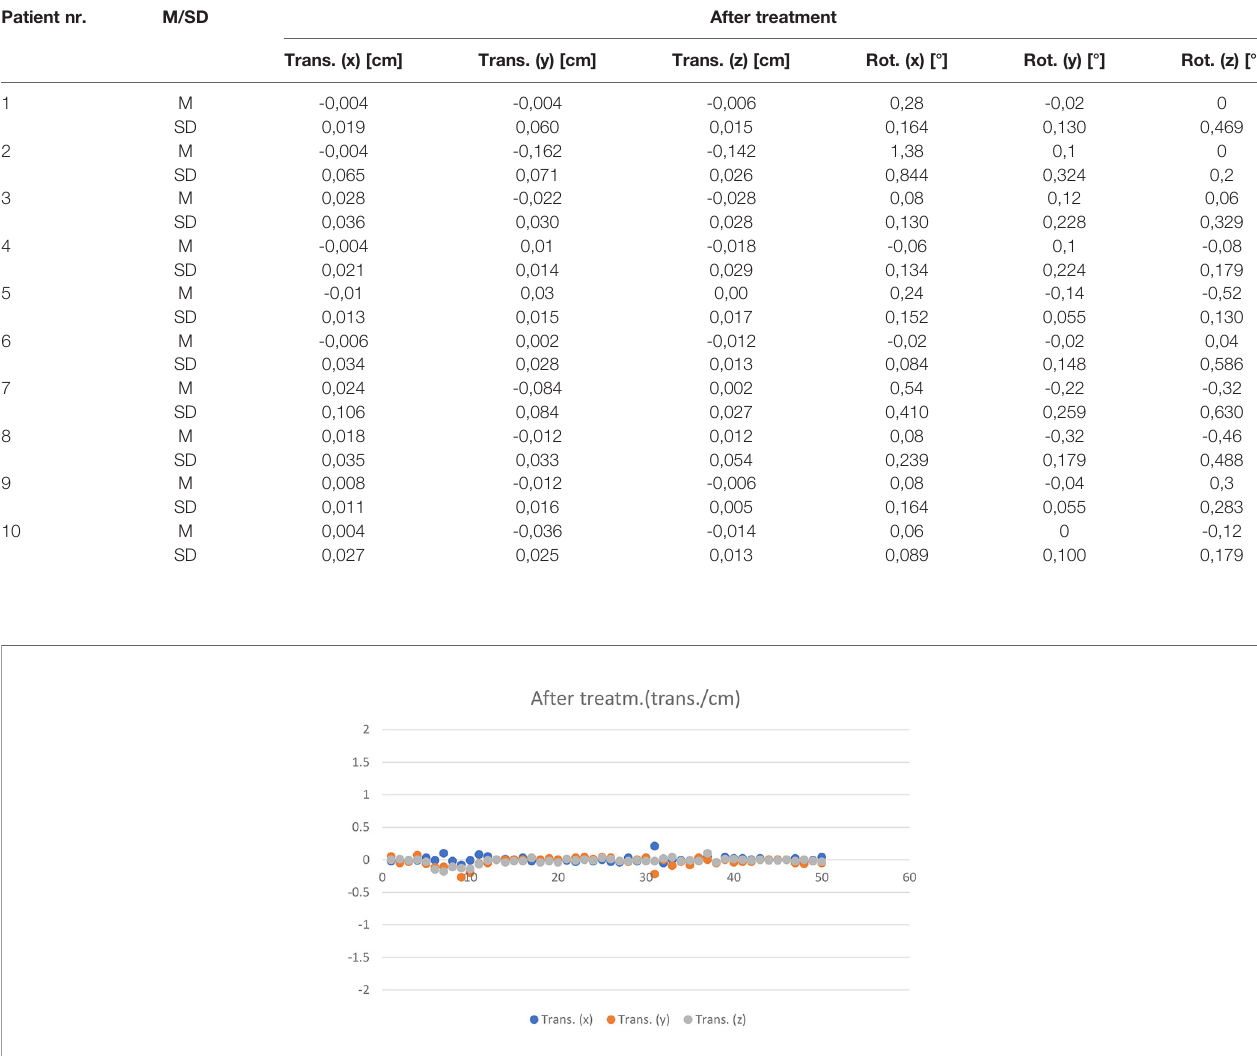
TABLE 3 | Mean and standard deviation of post-treatment HR 3D CBCTs per patient. Patient